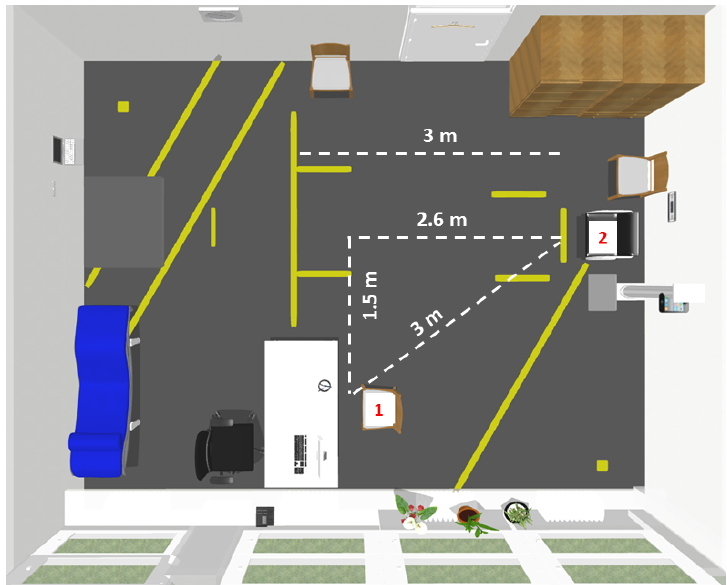
Figure 10. Sketch of our laboratory. Within a semi-unsupervised situation, the participants change from Chair 1 to Chair